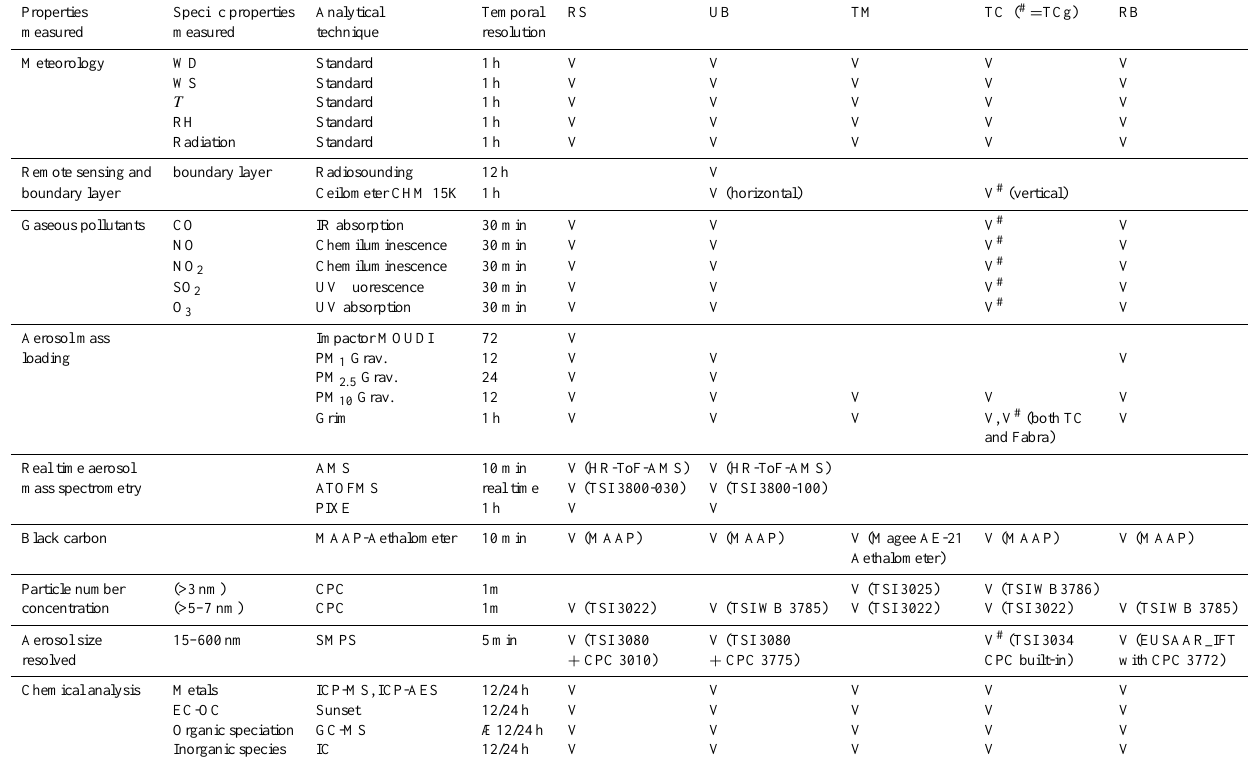
Table 2. Summary of measurements taken during SAPUSS.